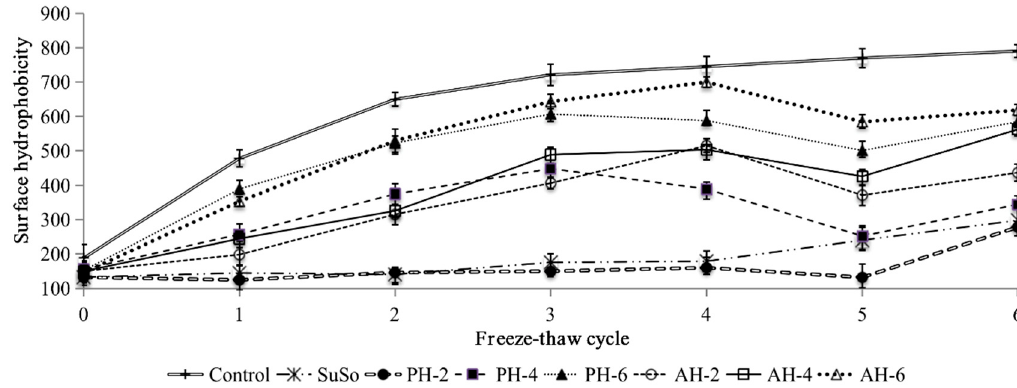
Figure 5. Surface hydrophobicity of actomyosin from different surimi samples during freeze-thaw cycles. SuSo (surimi added with sucrose-sorbitol blend); PH-2, PH-4 and PH-6 (surimi with addition of 2, 4, and 6 g of the hydrolysate prepared by Protamex hydrolysis, respectively); AH-2, AH-4 and AH-6 (surimi with addition of 2, 4, and 6 g of the hydrolysate prepared by Alcalase hydrolysis, respectively); and control (surimi without cryoprotectant). The reported data represent mean values from three replications. Bars represent standard deviations.